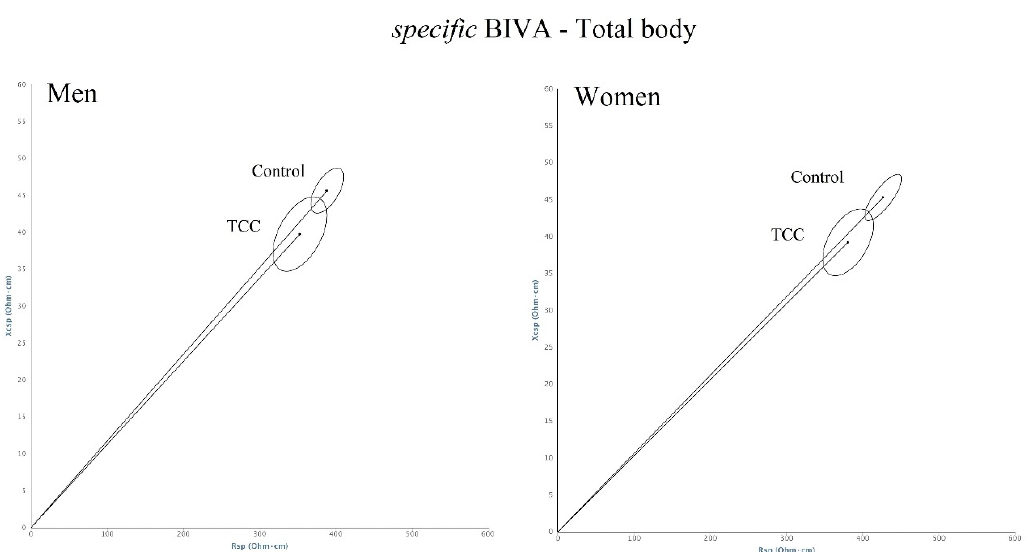
Figure 2. Total body confidence ellipses. Comparison between the Tai Chi Chuan (TCC) group and controls. Men: T 2 = 6.6, p = 0.047; women: T 2 = 8, p = 0.023.